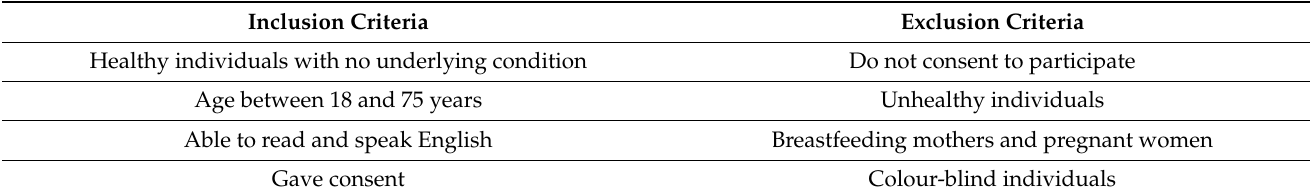
Figure 1. The study protocol of the stress monitoring study included three stress-inducing tasks/sessions, two self-reporting questionnaires sessions, and in-between rest sessions. Table 1. Selection criteria.